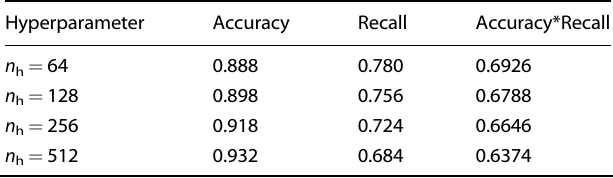
Table 4. Validation results for CNN layers.